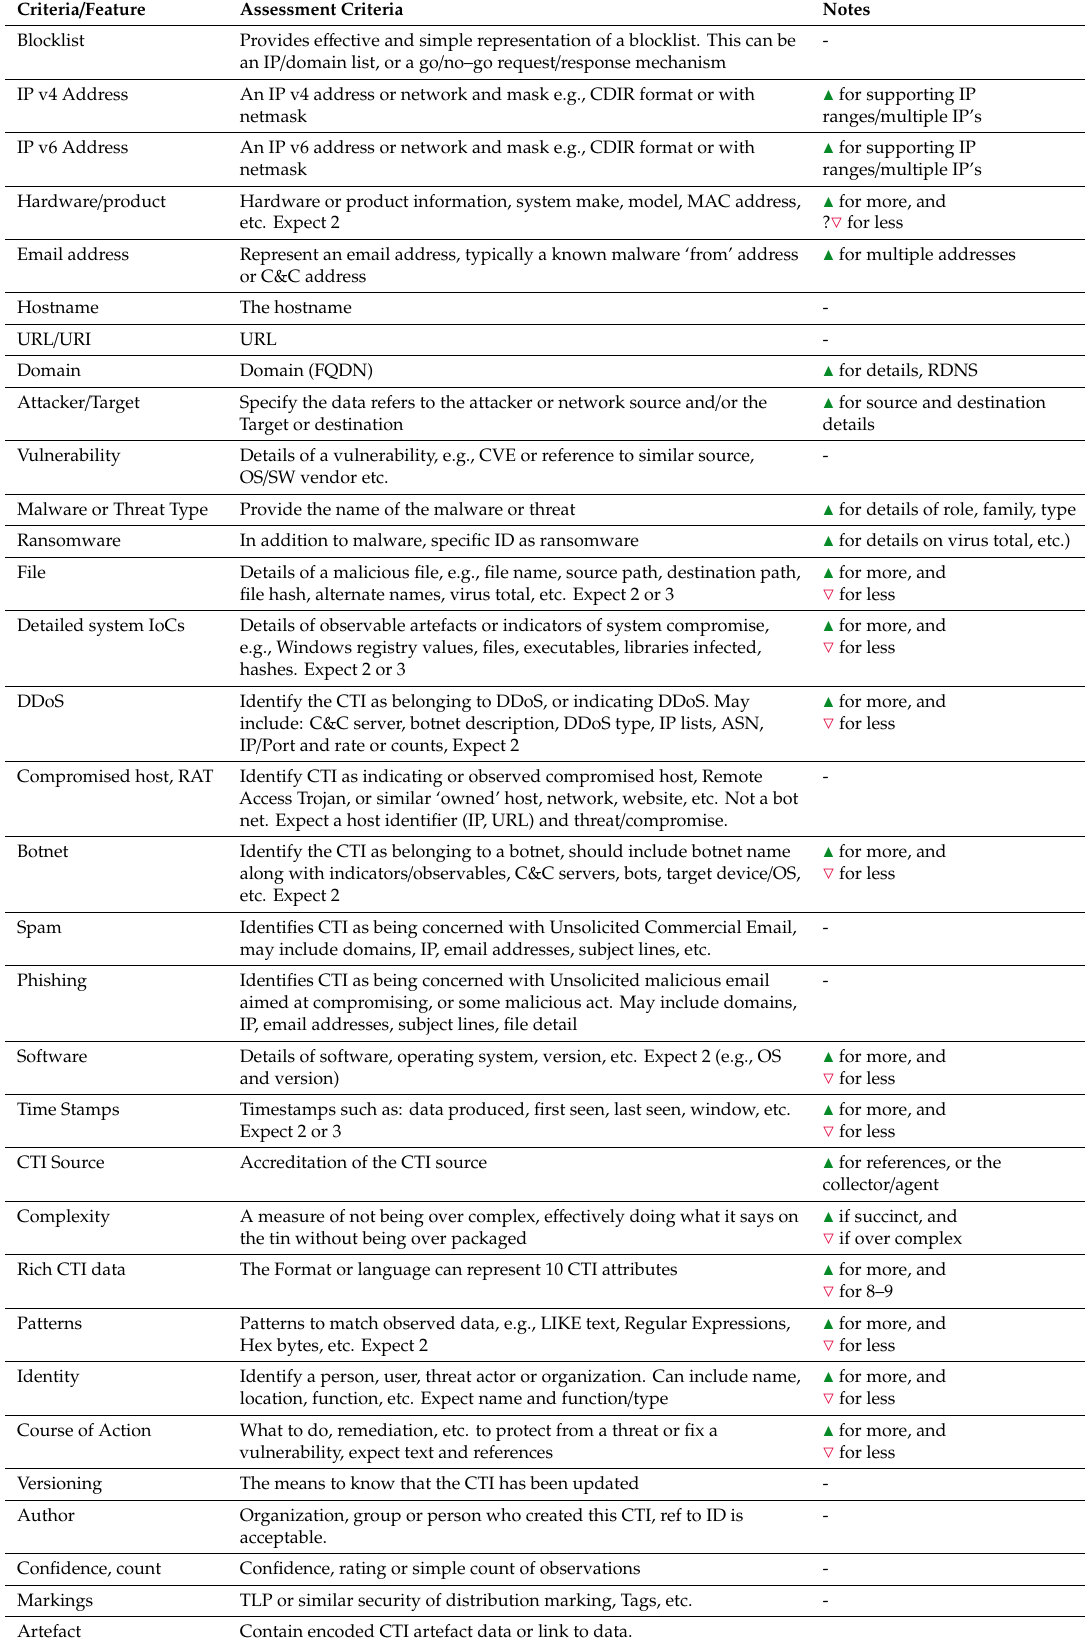
Table 6. Format and Languages, Assessment